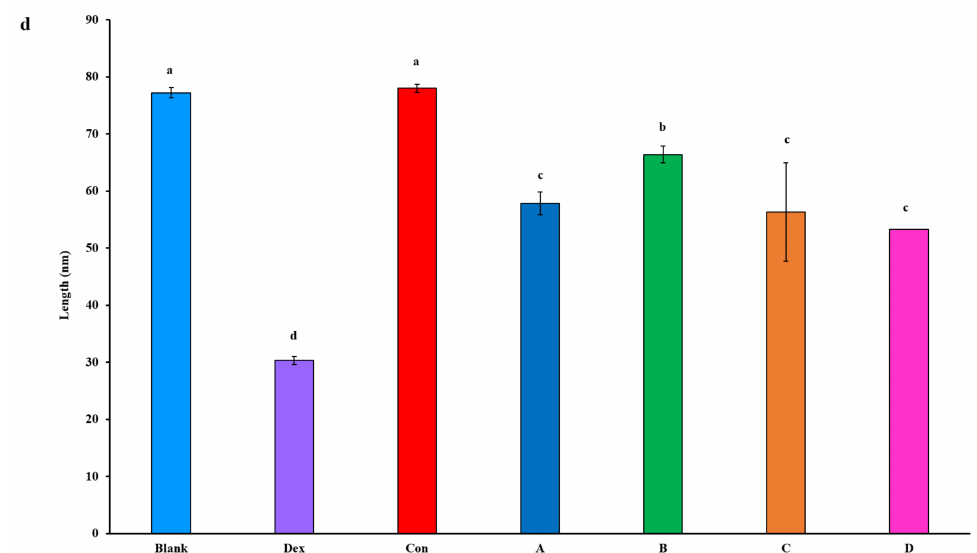
Figure 7. ( a ) Morphological observation of C2C12 myotubes; ( b ) PAS staining of C2C12 myotubes; ( c , d ) quantification of C2C12 myotubes. Blank = normal C2C12 cells; CON = DEX-induced and treated with BCAA; DEX = C2C12 cells induced by DEX; ( A – D ) = DEX-induced C2C12 cells and treated with 200 mg/mL of samples A, B, C, and D. Lowercase letters in the same column indicate significant differences according to Duncan’s multiple range tests ( p < 0.05).